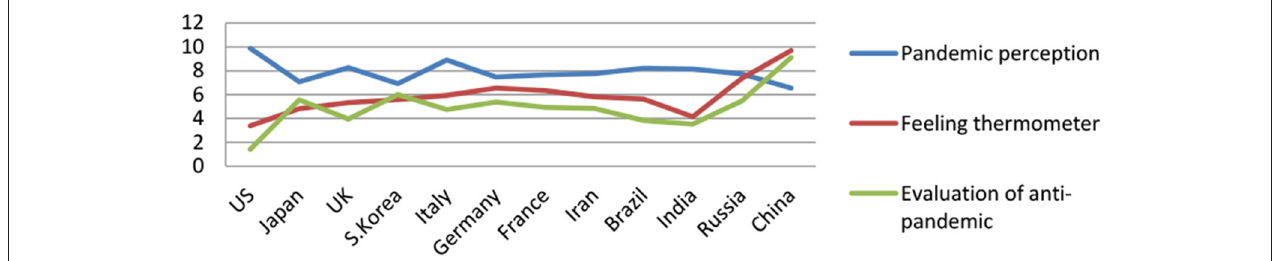
FIGURE 1 | Evaluation of controlling-pandemic, feeling thermometer and pandemic perception of Chinese public on different countries ( N = 619).